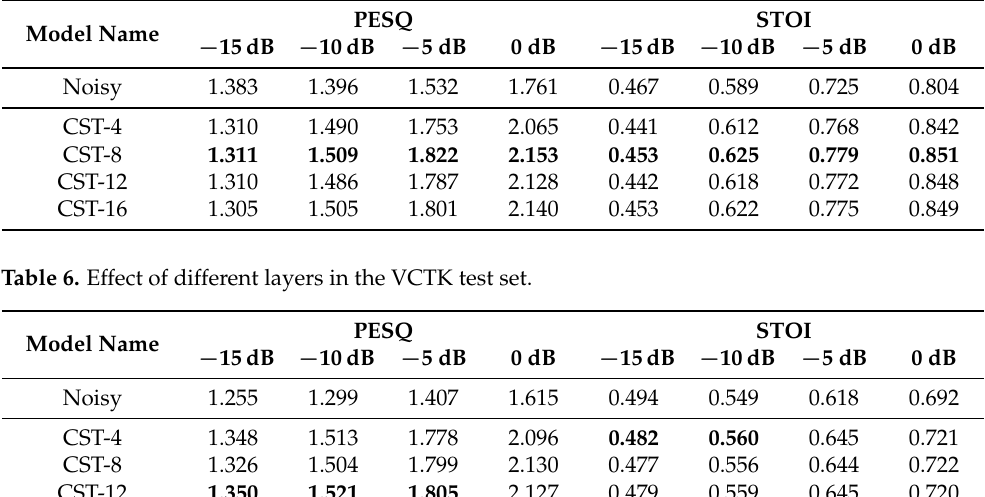
Table 5. Effect of different layers in the Babble test set.